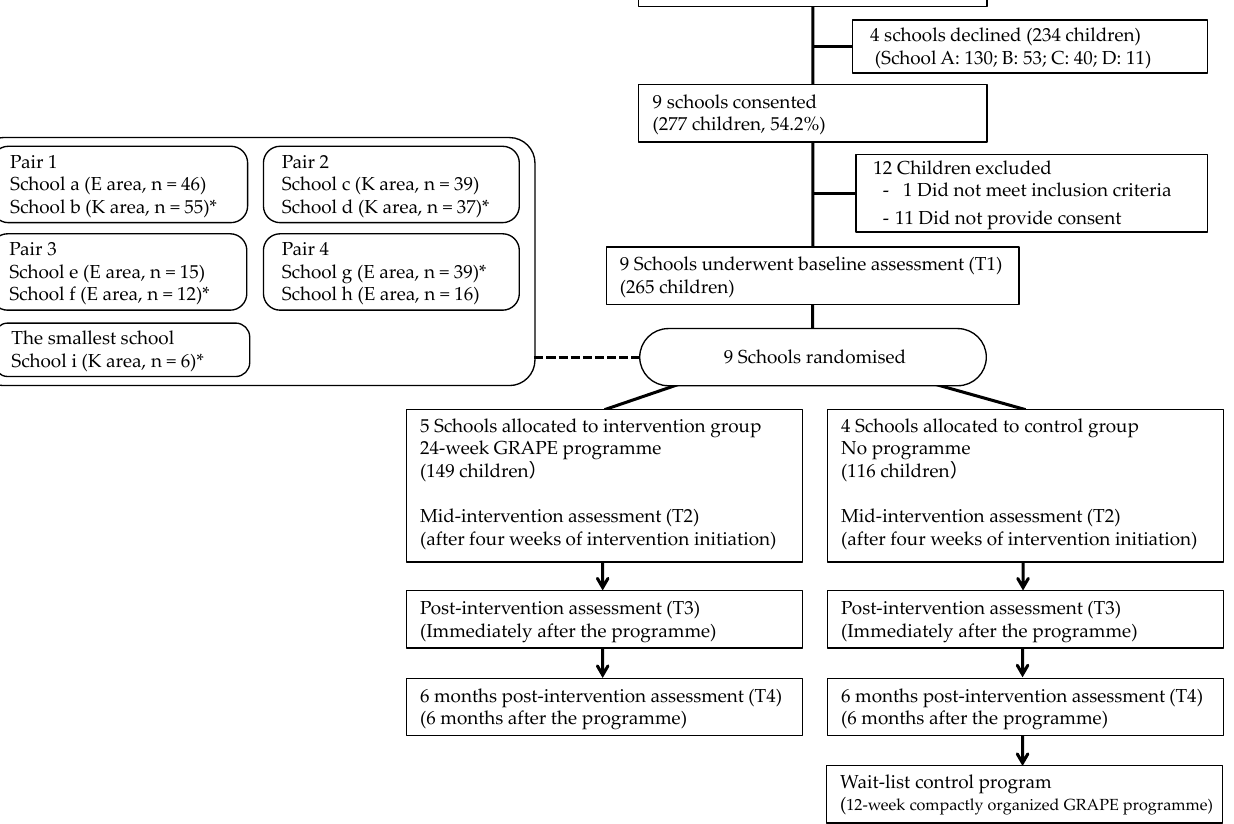
Figure 1. The flow diagram of the study protocol. GRAPE, Group activity, Active Play and Exercise; E area, Enzan area; K area, Katsunuma area; * indicates intervention group.